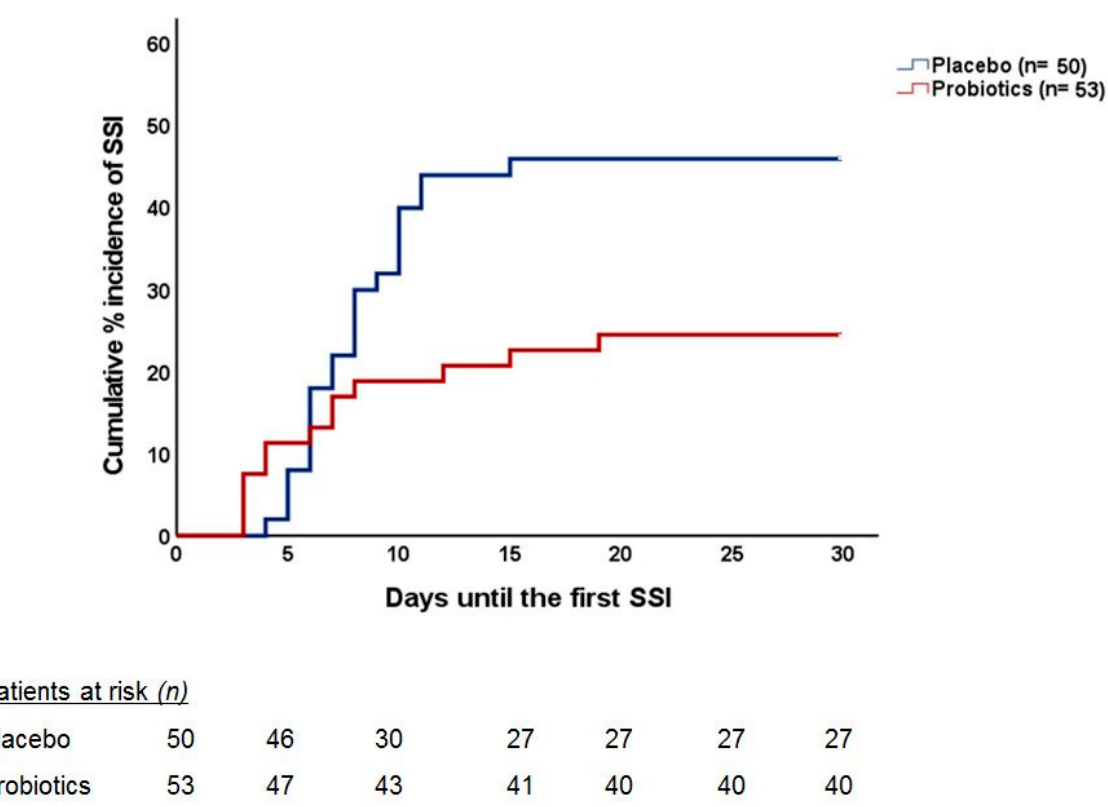
Figure 1. Cumulative incidence of SSI occurrence during the postoperative period in each group. The curves indicate the time to the incidence of the first episode of SSI in each group. The number of patients at risk over follow-up is indicated. The two curves are compared using Cox regression analysis; the Hazard Ratio (HR) of the incidence of SSI under probiotic intake compared to placebo intake is provided alongside the respective confidence intervals (CIs); the p -value of the difference between the two curves is also provided.